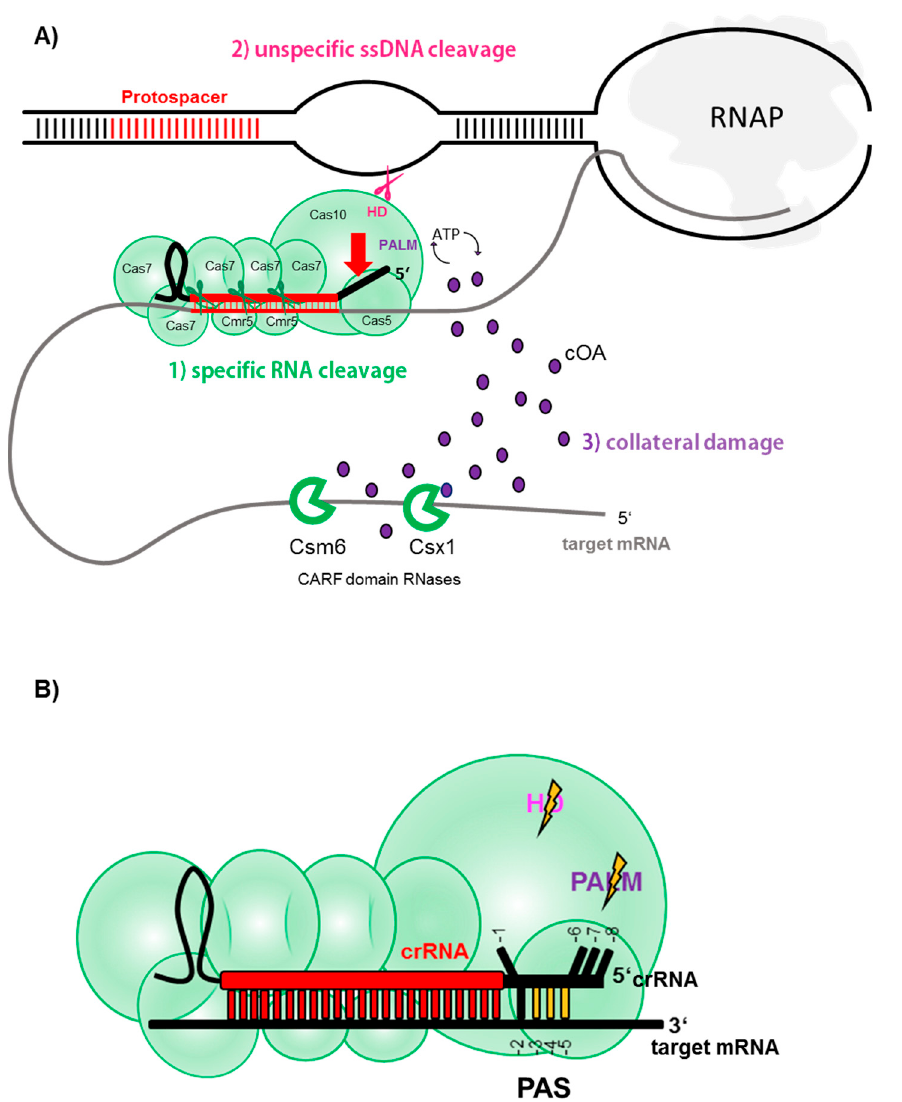
Figure 2. Activated and deactivated immune response of CRISPR type III complex. ( A ) The three phases of type III – mediated immunity are activated when a nascent mRNA is recognized by a crRNA in a type III complex. (1) Specific RNA cleavage: The Cas7 backbone cleaves the mRNA specifically at the protospacer region. (2) Unspecific ssDNA cleavage: When crRNA 5 ′ handle and PAS are unpaired (red arrow), the HD domain (pink) of the large subunit Cas10 is activated and mediates sequence-unspecific ssDNA cleavage of nearby DNA bubbles. (3) Collateral RNA shredding: As in the case for ssDNA activation, the PALM domain (violet) in the large subunit Cas10 is activated if the 5 ′ handle is unpaired to the PAS (red arrow). The PALM domain converts ATP into cyclic oligoadenylates which bind to the CARF domain of RNases, such as Csm6 and Csx1, thereby activating nonspecific RNA shredding. ( B ) Base pairing between the 5 ′ handle of the crRNA and the 3 ′ PAS. Complementarity in regions -3, -4, -5 deactivates HD and PALM domain activity, thereby only allowing specific RNA cleavage mediated by the backbone of the complex. Nucleotides in position - 1, -6, -7, -8 do not contribute to base pairing, as they are distorted (-1), or tightly bound into specific pockets (-6, -7, -8).